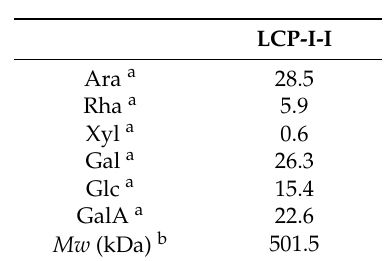
Table 1. Monosaccharide composition (mol %) and Mw (kDa) of polysaccharide fraction LCP-I-I obtained from rhizomes of L. chuanxiong .